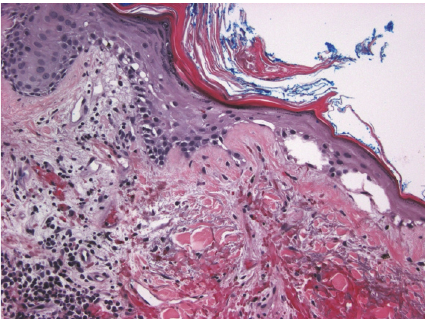
Figure6:Marrowreticulinfibersmoderatelyincreasedwithstorage iron present (bone marrow biopsy, left posterior iliac crest, and reticulin stain,